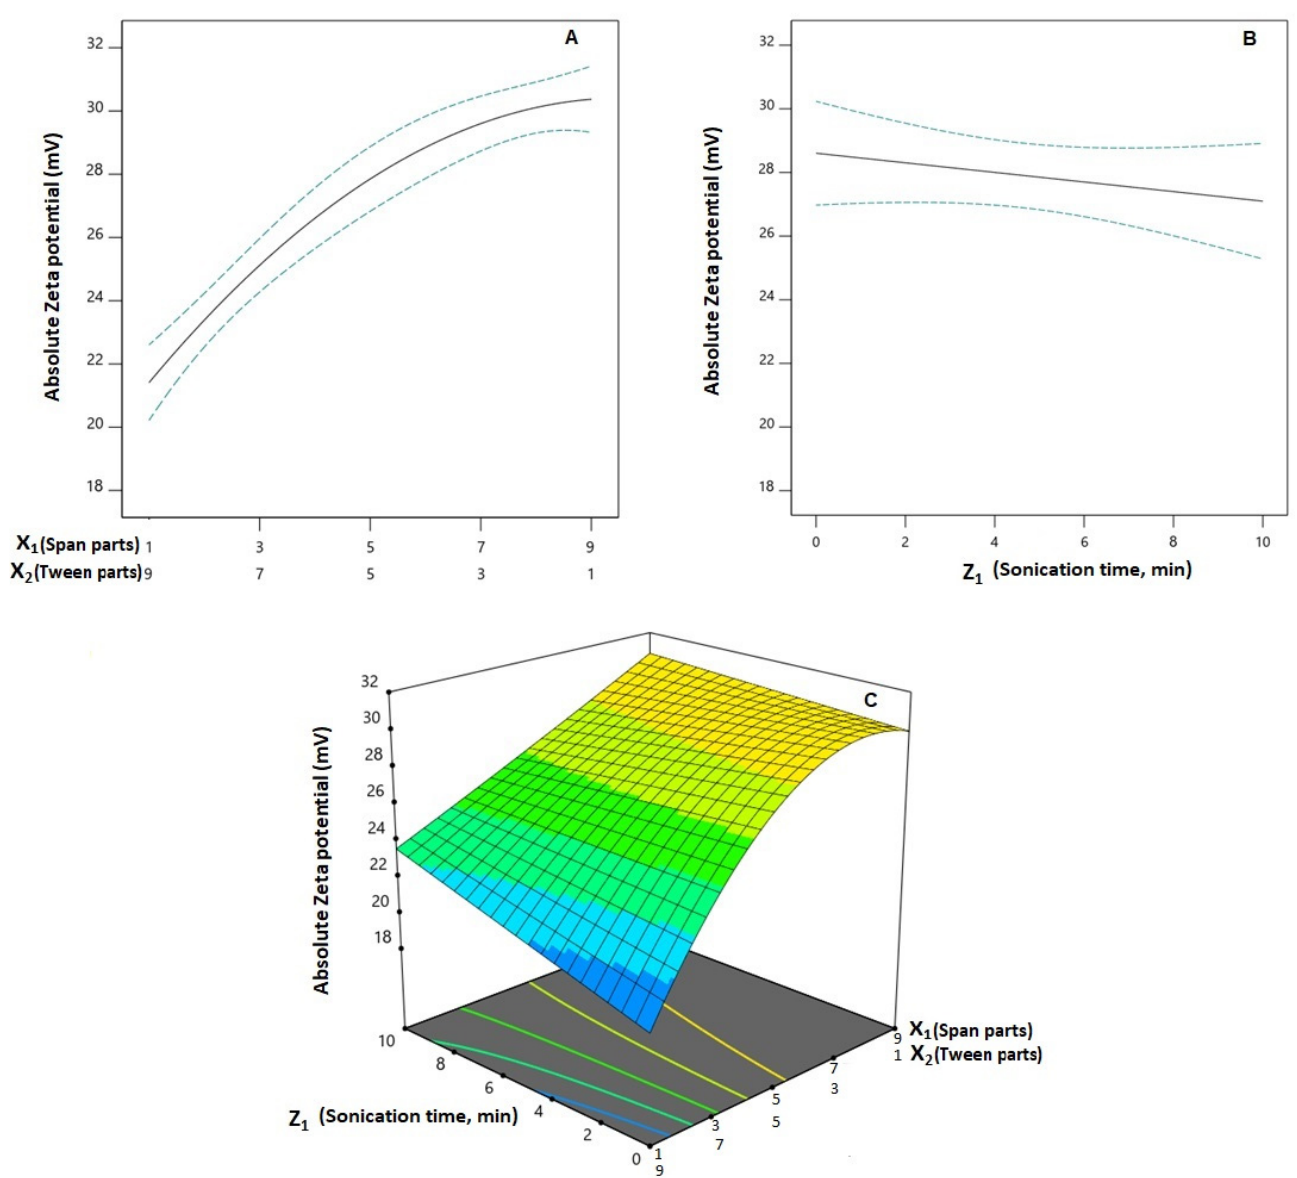
Figure 4. One-factor plots for the effect of the binary mixture components ( A ) and the sonication time ( B ) at the mid-values of the other variables on absolute zeta potential (Y 3 ); three-dimensional mixture-process plot ( C ) for the interaction between mixture components and sonication time. Abbreviations : SMV, simvastatin; SPNs, spanlastics; X 1 , Span 20 parts; X 2 , Tween 60 parts (X 1 and X 2 add up to 10 parts)